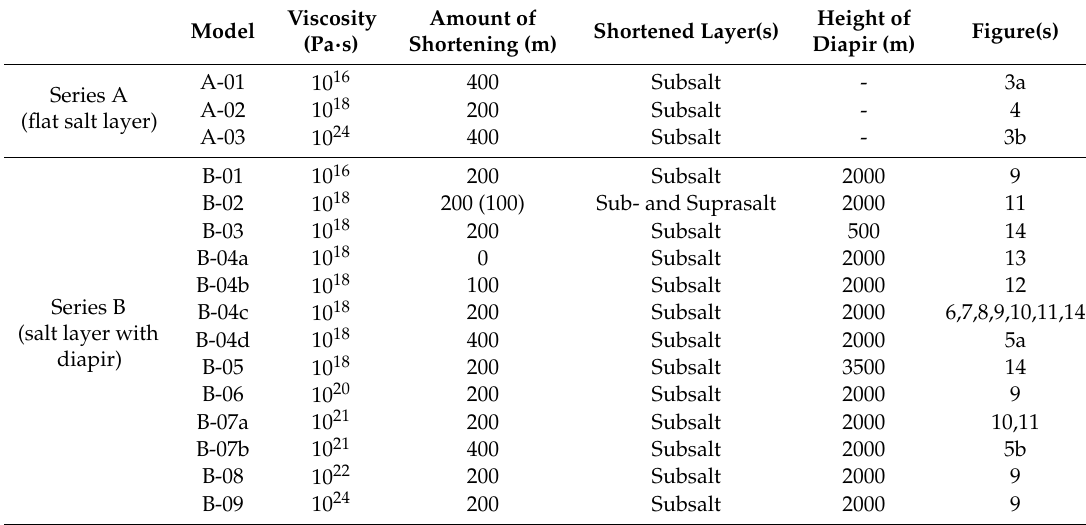
Table 1. Overview of model